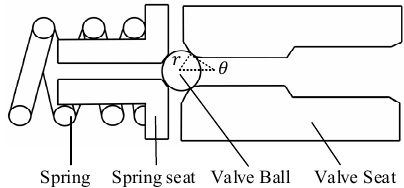
Figure 1. The structure of the pressure relief valve.